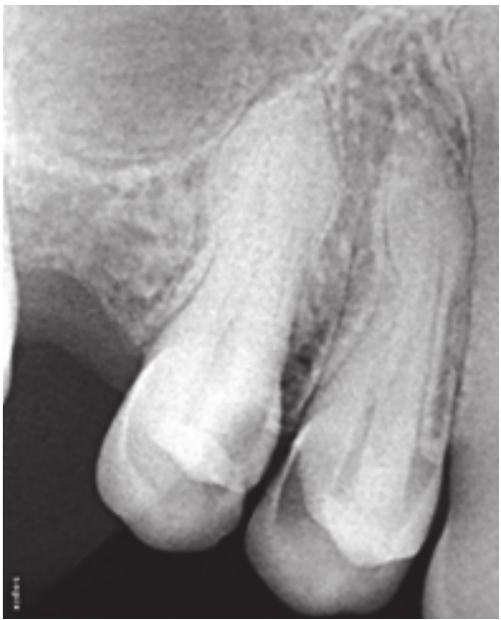
Figure 3: Intraoral periapical radiograph of #14 and #15 region shows coronal radiolucency in 14 (distal) and 15 (mesial). The radiolucencyapproximatestothepulp.ThereisalsoevidenceofPDL widening in both teeth.